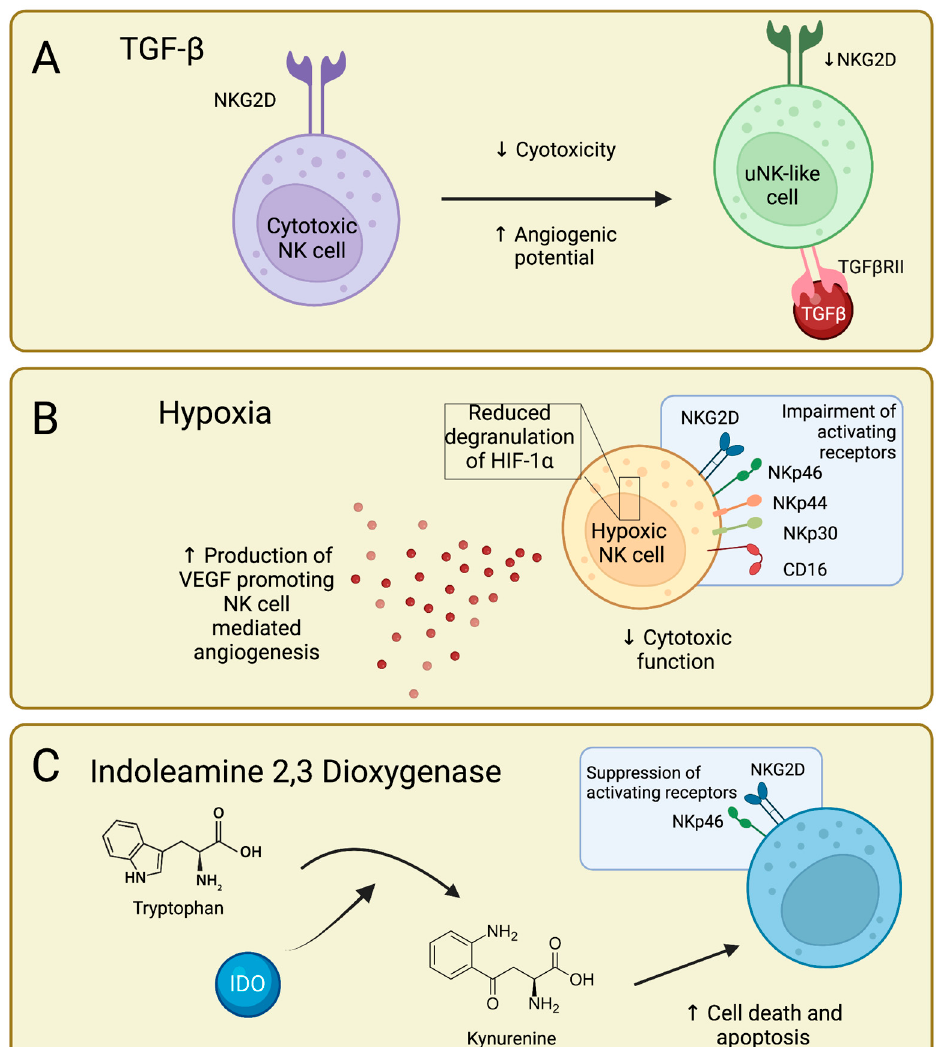
Figure 2. NK cell suppression. Schematic showing NK cell suppression after exposure to ( A ) TGF β , ( B ) hypoxia, or ( C ) IDO. Figure created with BioRender (https://www.biorender.com/ [accessed on 10 February 2013]) .